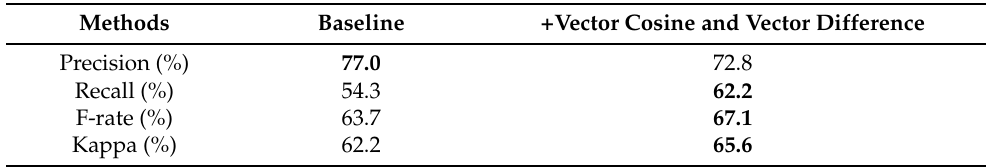
Table 4. The results of the designed similarity comparison module.